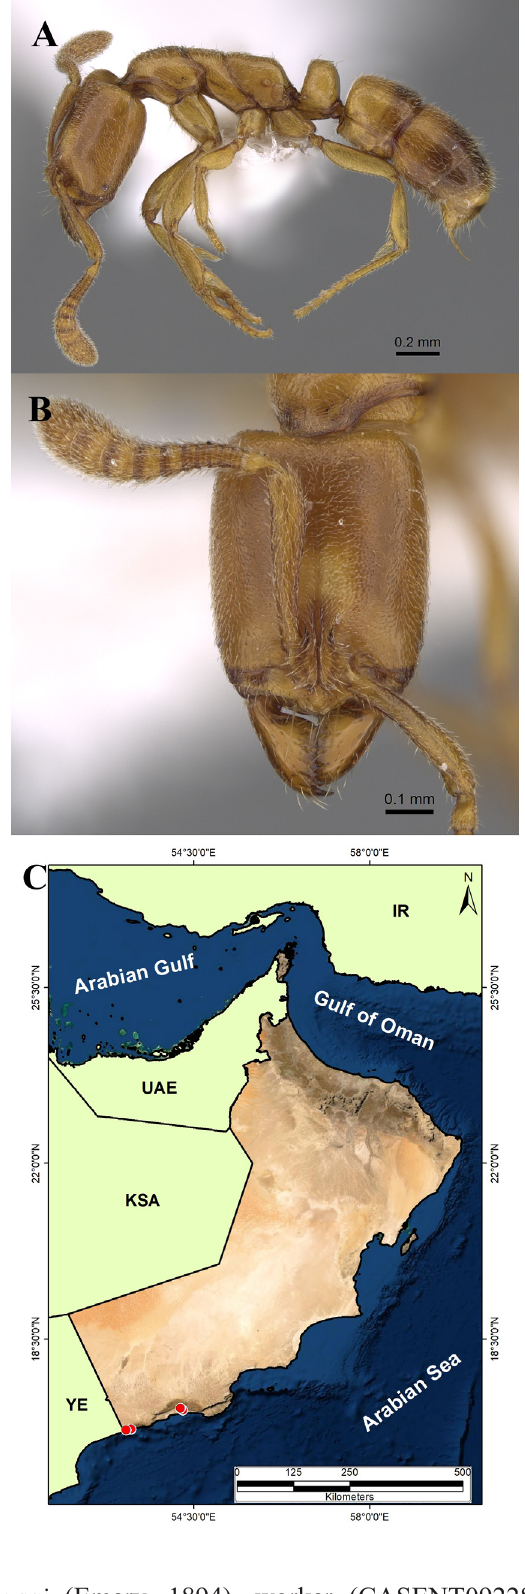
Fig. 54. Hypoponera ragusai (Emery, 1894), worker (CASENT0922863, AntWeb.org (Michele Esposito)). A . Body in profile. B . Head in full-face view. C . Distribution